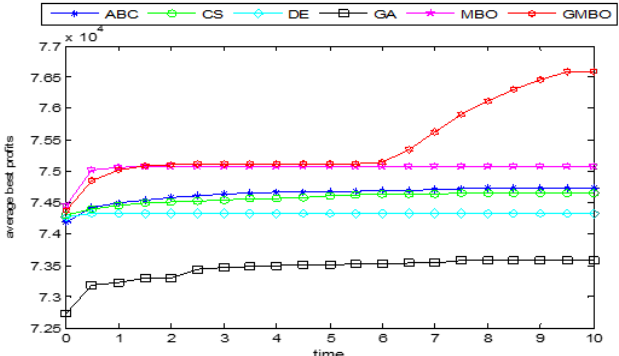
Figure 19. The convergence graph of six methods on KP4 in 10 seconds.